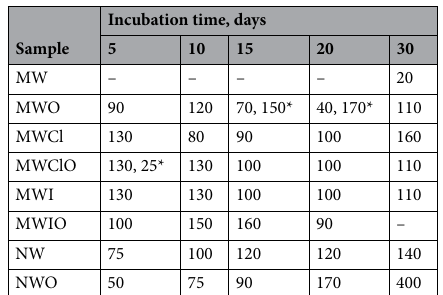
Table 4. Hydrodynamic radii of colloidal particles during the experiment, nm (The measurement accuracy was at least 2%.). We employed the Dynamic light scattering method using the Compact-Z particle size and zeta potential analyzer (Photocor, Russia). *Two groups of particles